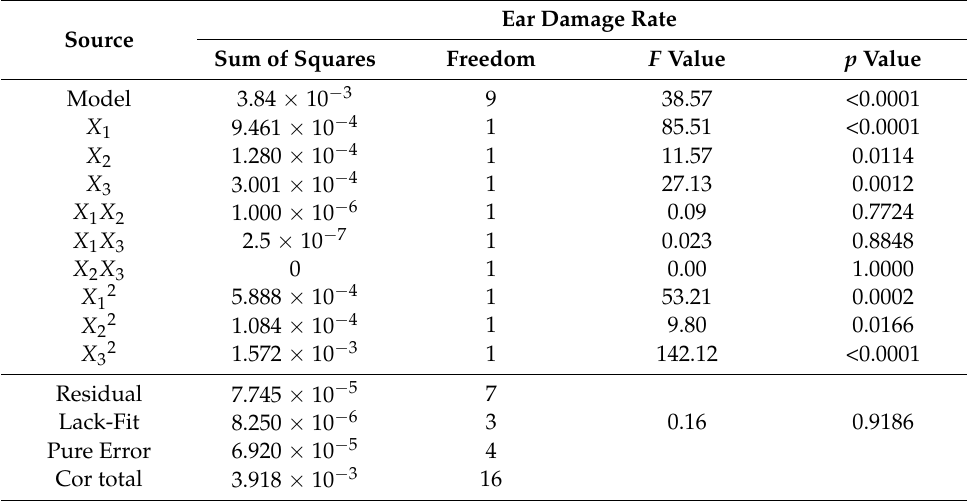
Table 5. Variance analysis of regression equation.